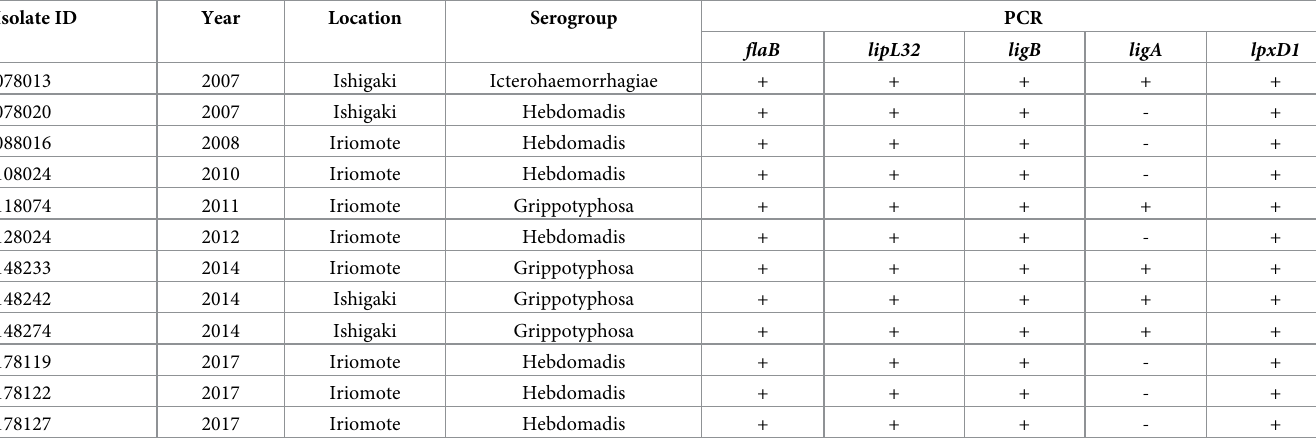
Table 2. Characterization of Leptospira human clinical isolates from the Yaeyama region. Isolate